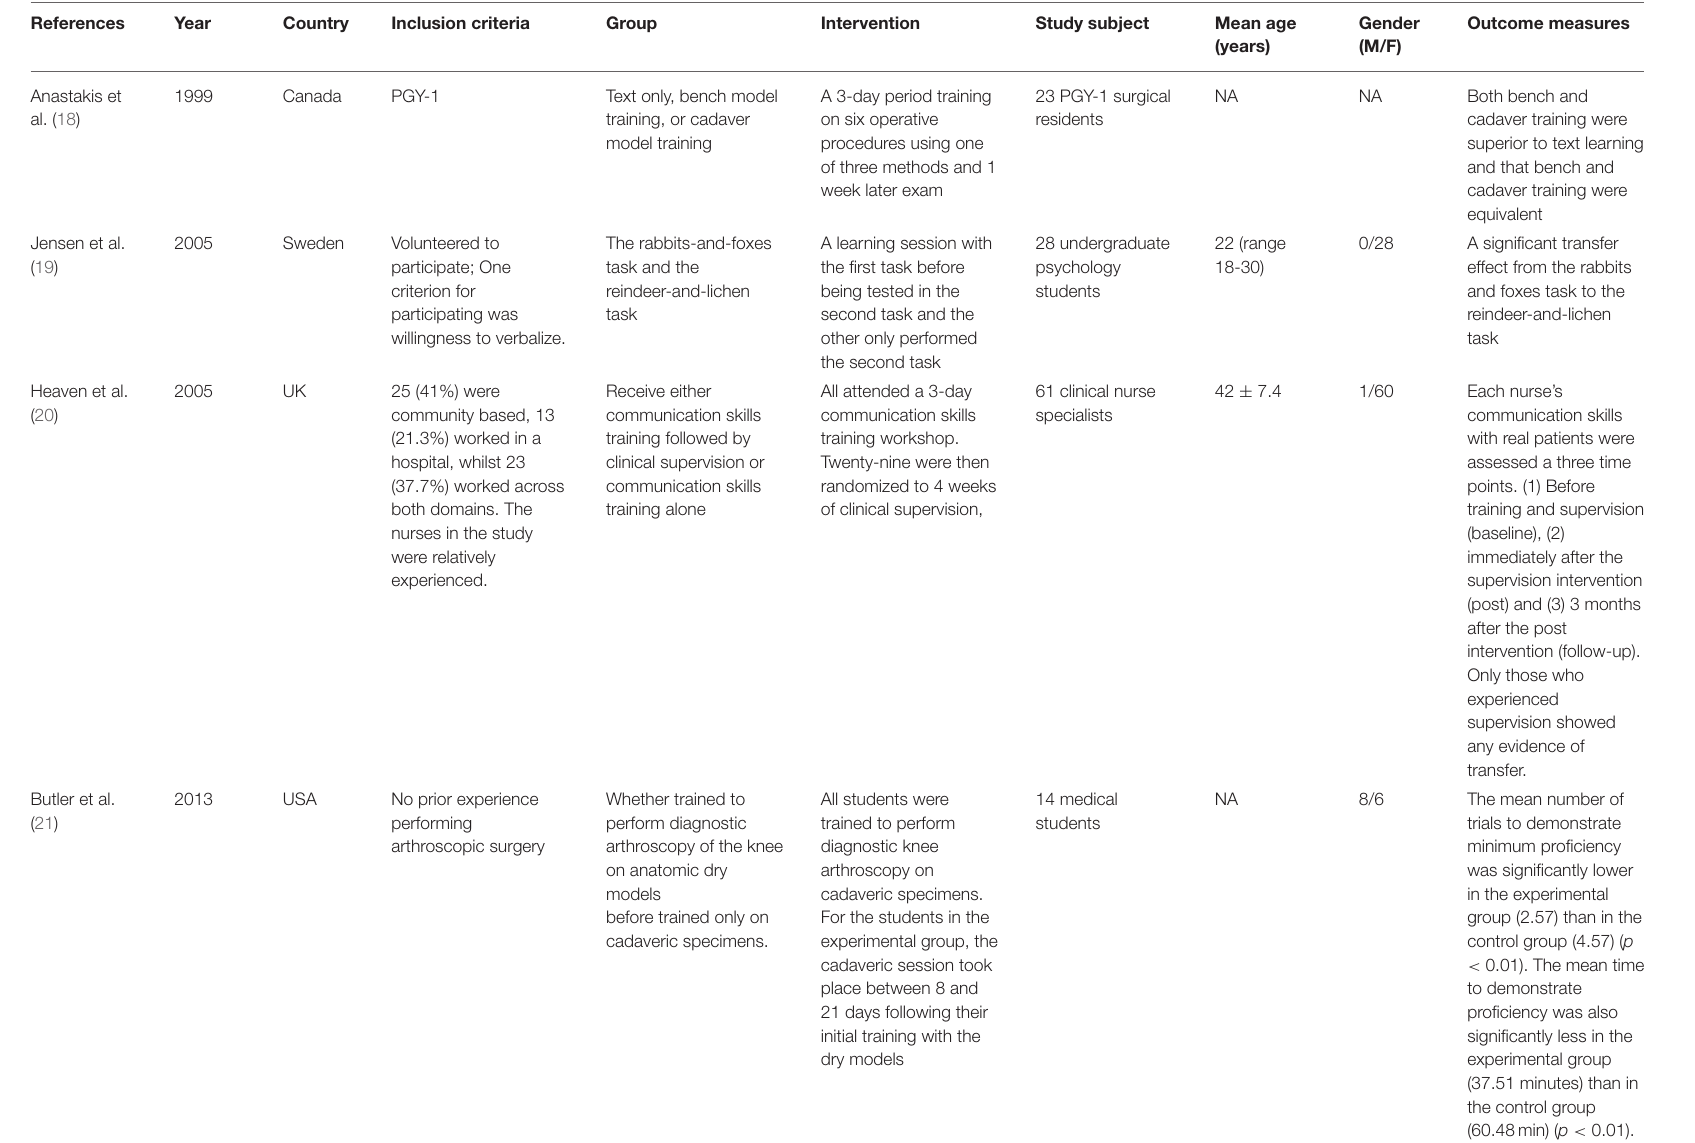
TABLE 2 | Characteristics of randomized controlled